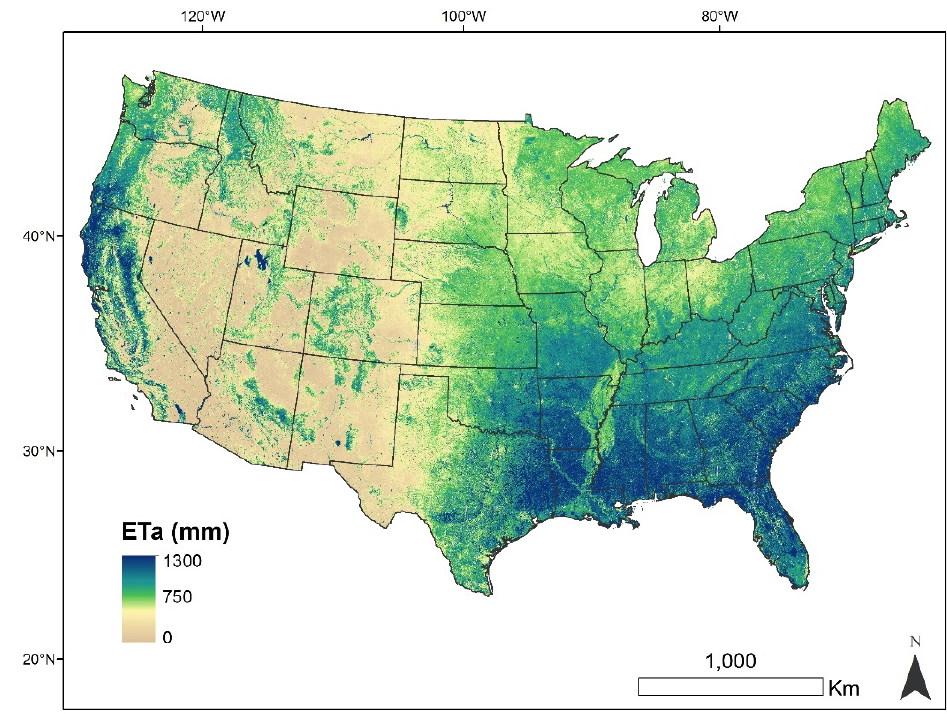
Figure 6. Annual SSEBop ETa using 5-water year median (2009, 2011, 2013, 2016, 2018) data from Landsat 5/7/8. Data were resampled to 250 m resolution for display. The data are available at https://doi.org/10.5066/P9NKWT3D (accessed on 27 December 2022) [38]. The individual water-year comparison also shows a negative bias from SSEBop v0.2.6